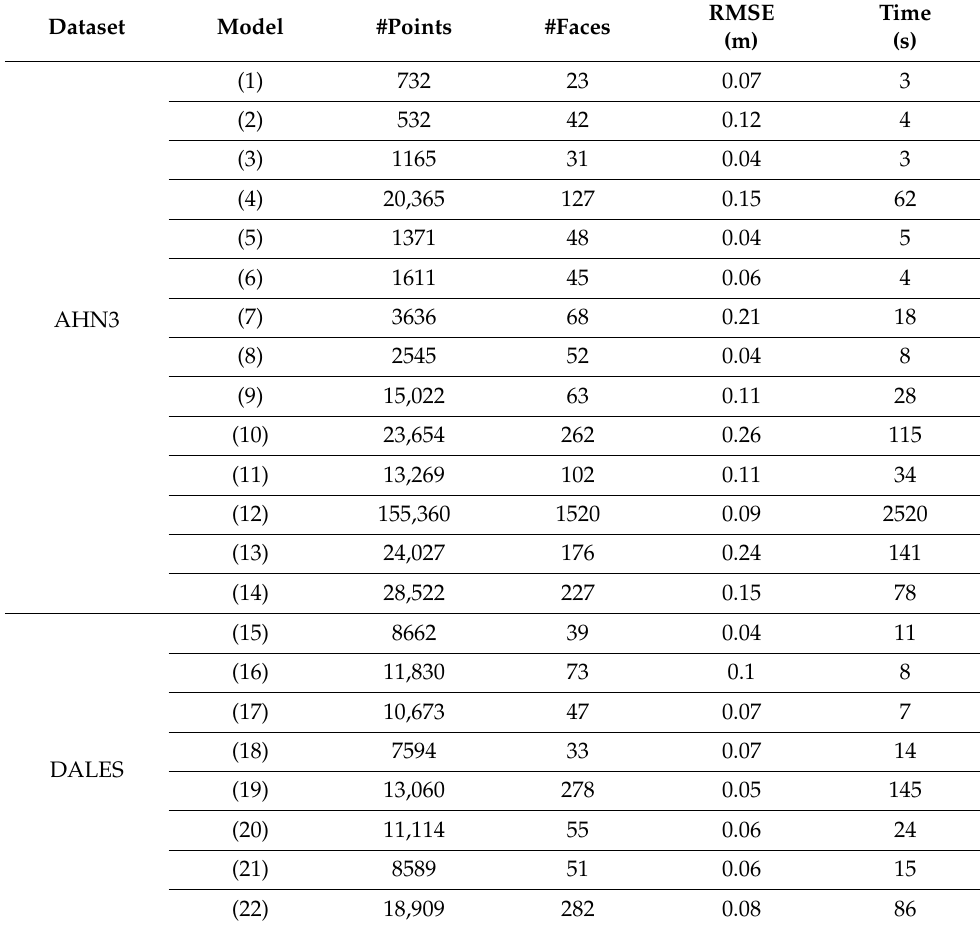
Table 1. Statistics on the reconstructed buildings shown in Figure 6. For each building, the number of points in the input, number of faces in the reconstructed model, fitting error (i.e., RMSE in meters), and running time (in seconds) are